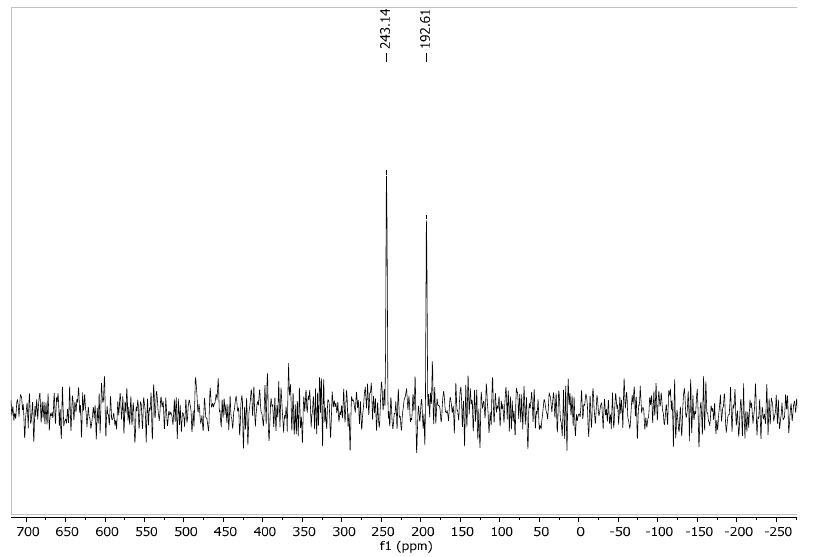
Figure 3. 15 N CP/MAS NMR spectrum of 1 .